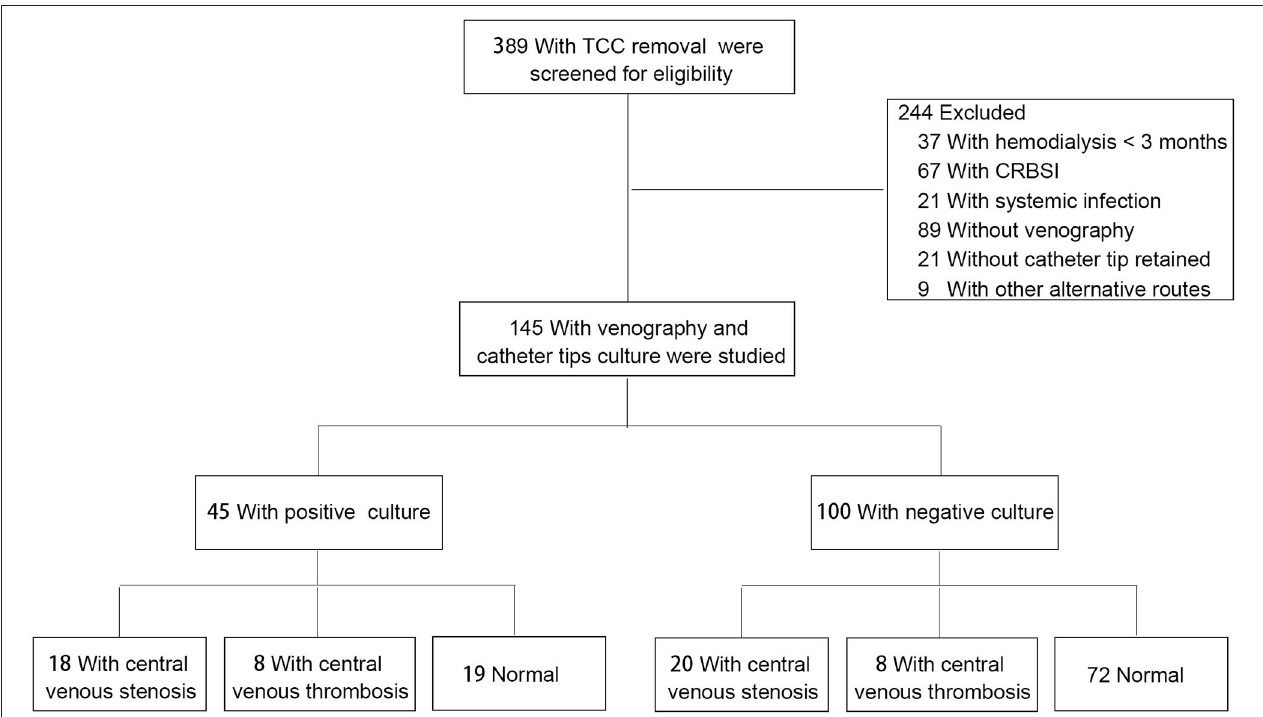
FIGURE 1 | Flow diagram depicting the design of the retrospective cohort